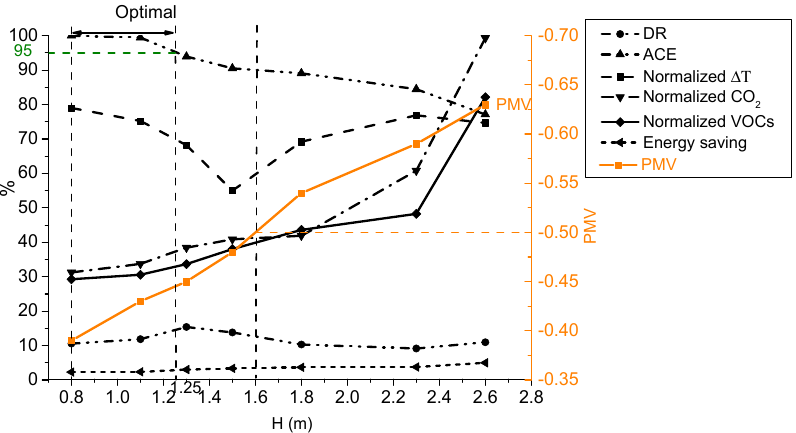
Figure 15. Comprehensive indices at different height of return air vent in heating mode. ∆ t C p head − ankle C p = concentration of contaminant Note: Normalized ∆ T = ; normalized concentration C n = C e 3 in breathing zone; C e = concentration of contaminant in exhaust